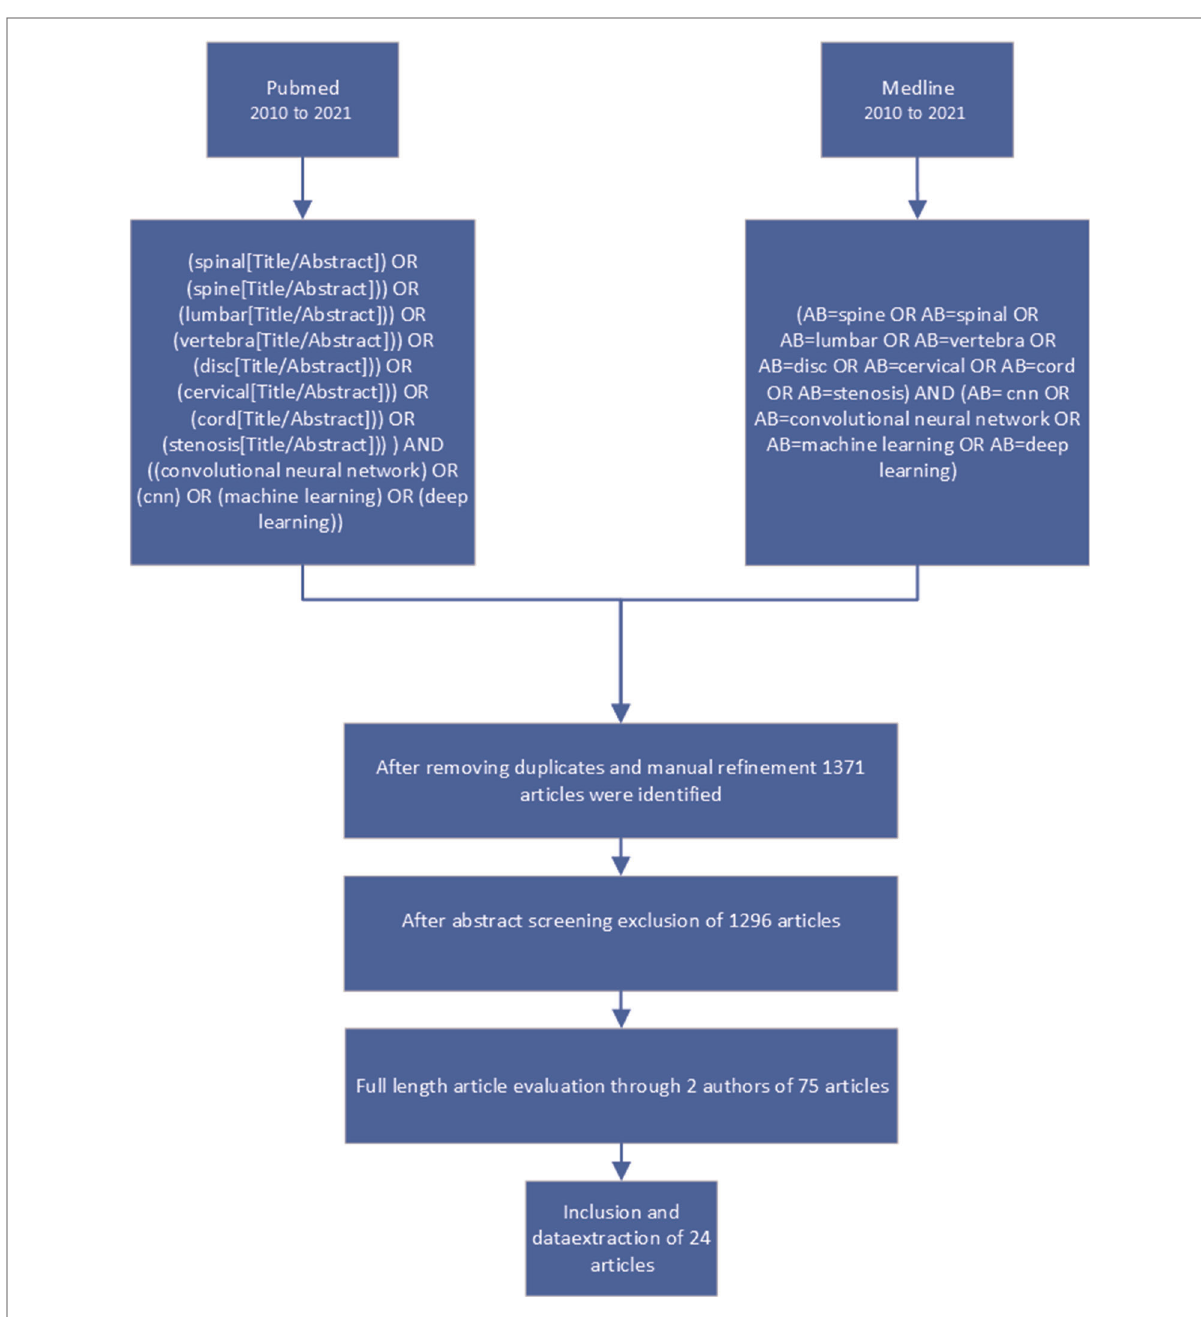
FIGURE 1 Selection process for the systematic review - fl ow